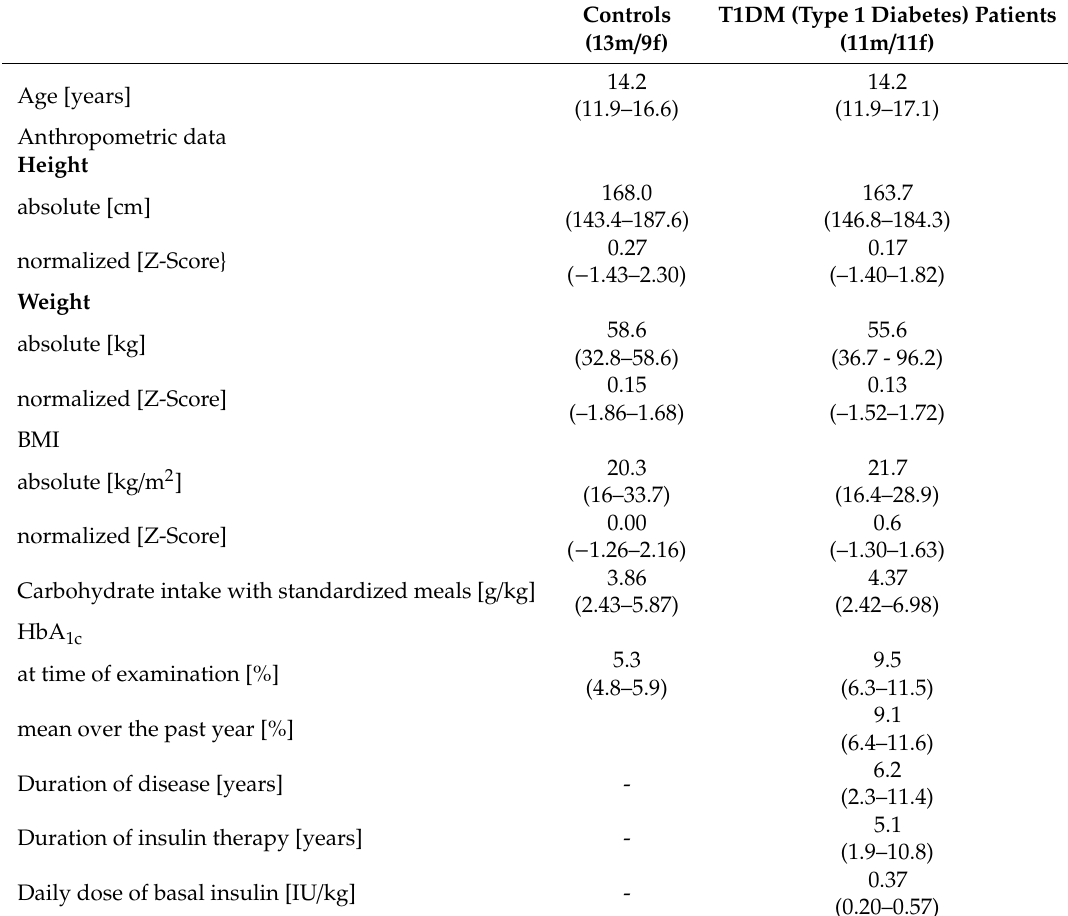
Table 1. Study population: Dietary, therapeutic, and demographic data (median and